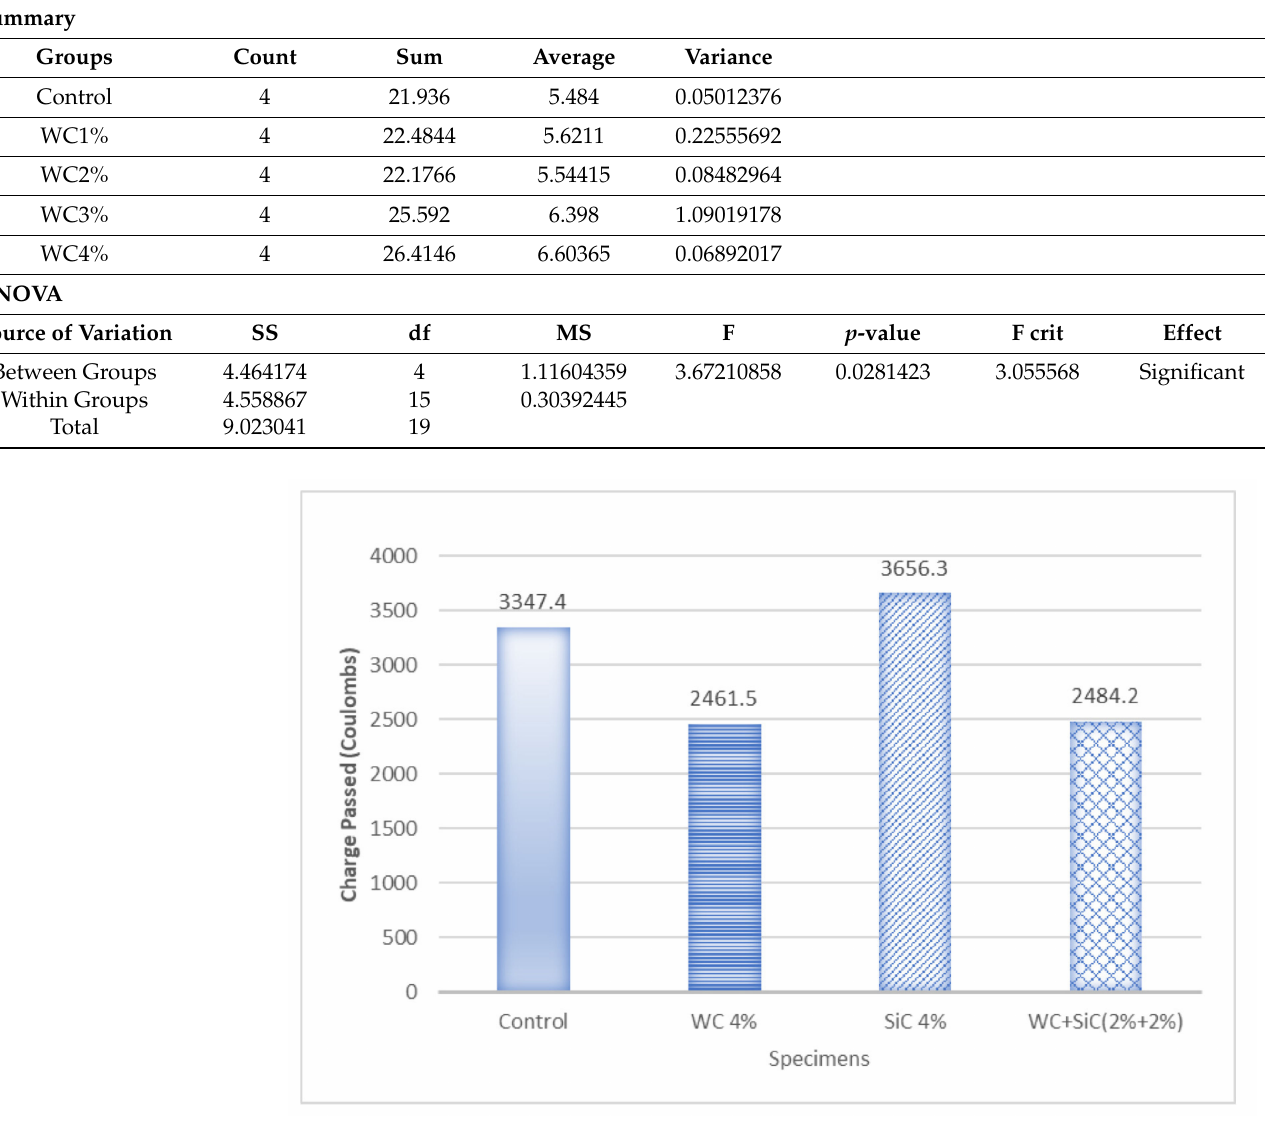
Figure 9. Rapid Chloride Permeability Test of